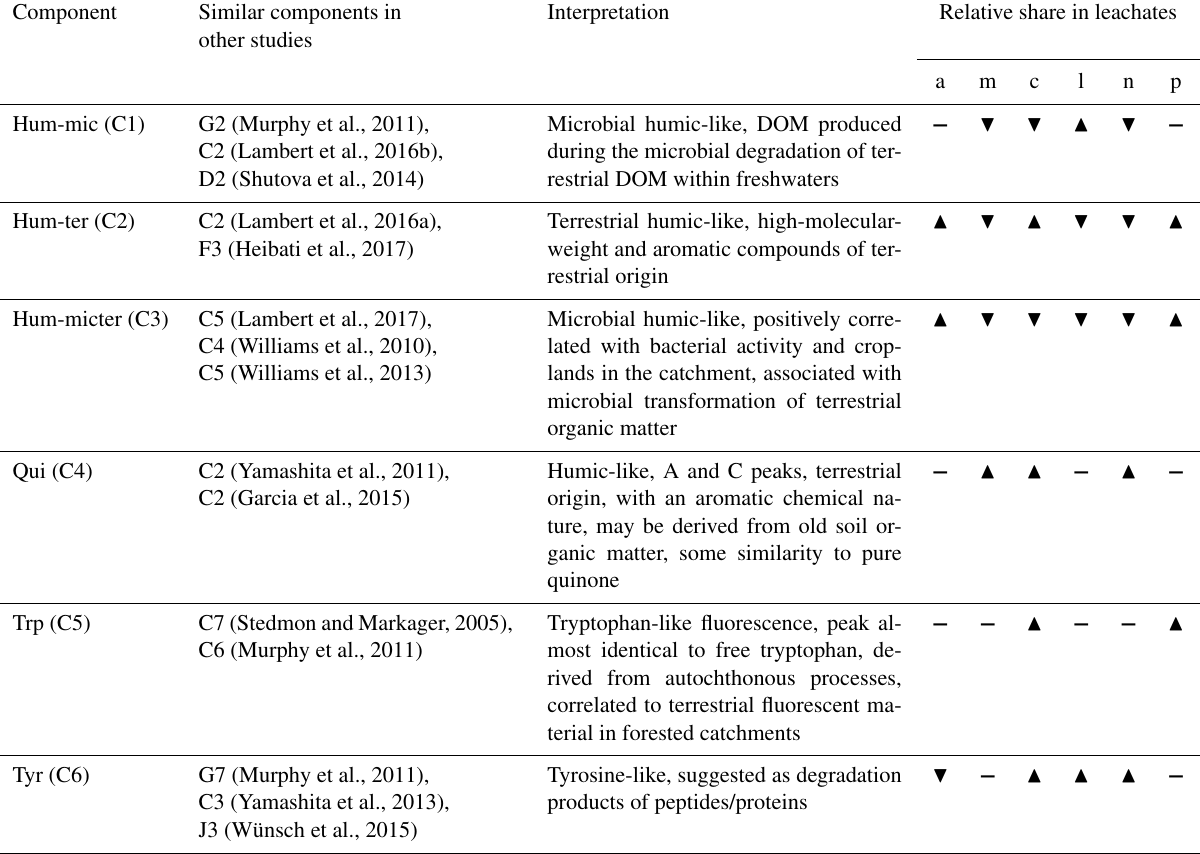
Table 2. PARAFAC components and their comparison to other studies. The abbreviations and symbols used stand for the following: a: ambient; m: corn; c: cow dung; l: leaves; n: nettles; p: pig dung; (cid:78) : high; − : intermediate; and (cid:72) : low.